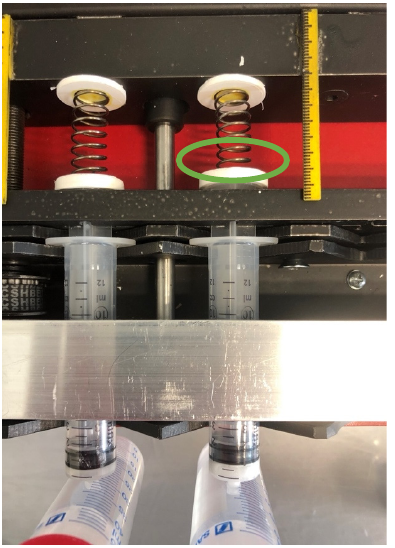
Figure 8. Top view on two units in the in vitro model—completion of agglomerate formation in the right syringes is indicated by the compression of the spring (indicated by green cycle).